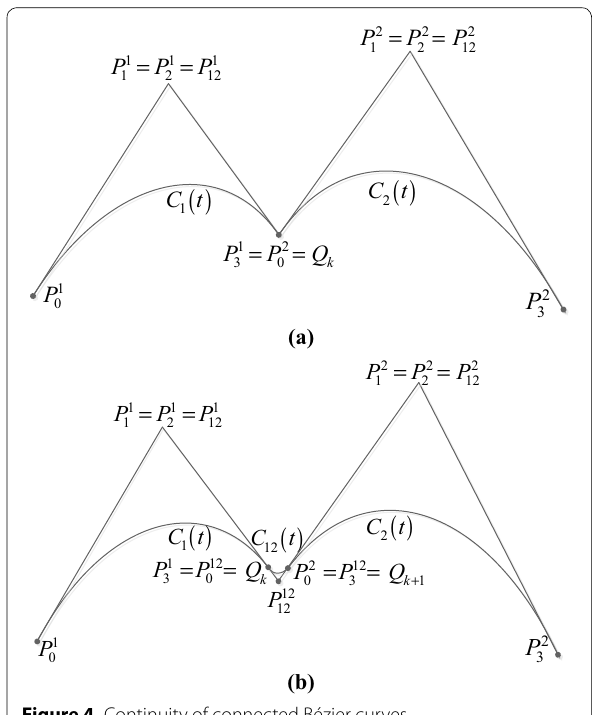
Figure 4 Continuity of connected Bézier curves